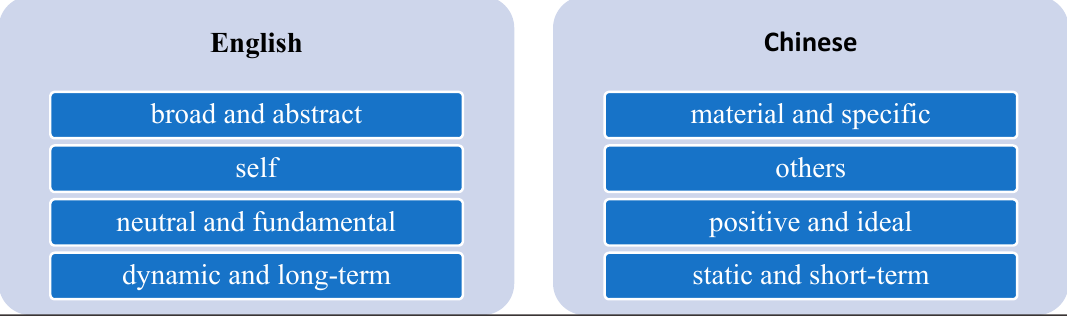
Figure 4. Chinese international students’ different understanding of wellbeing in English and Chinese.